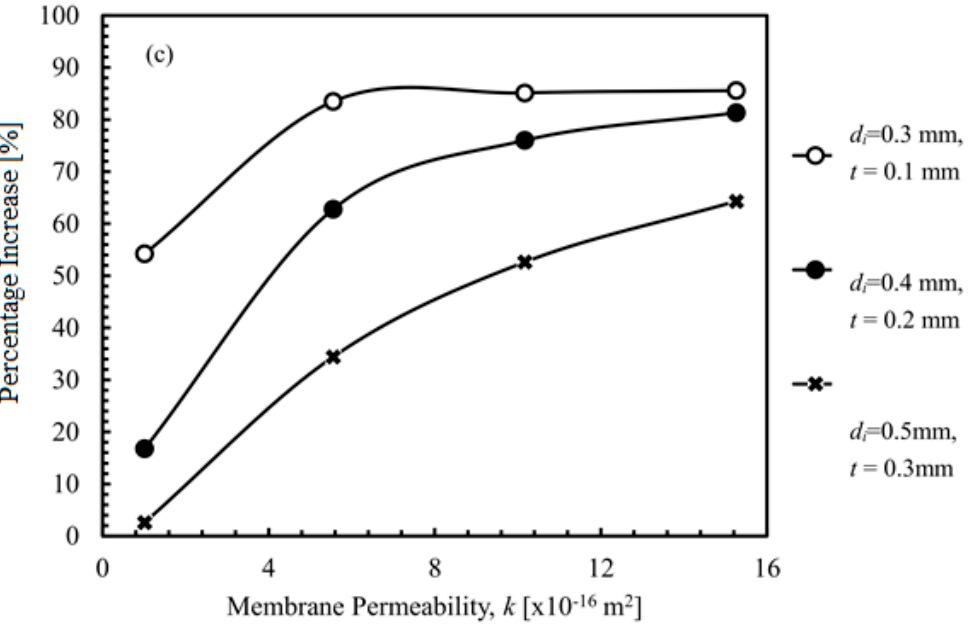
Figure 9. Relationship between membrane permeability and output flow rate for different fibre inner diameter and membrane thickness. ( a ) Single-end suction; ( b ) Double-end suction; ( c ) Percentage increase.